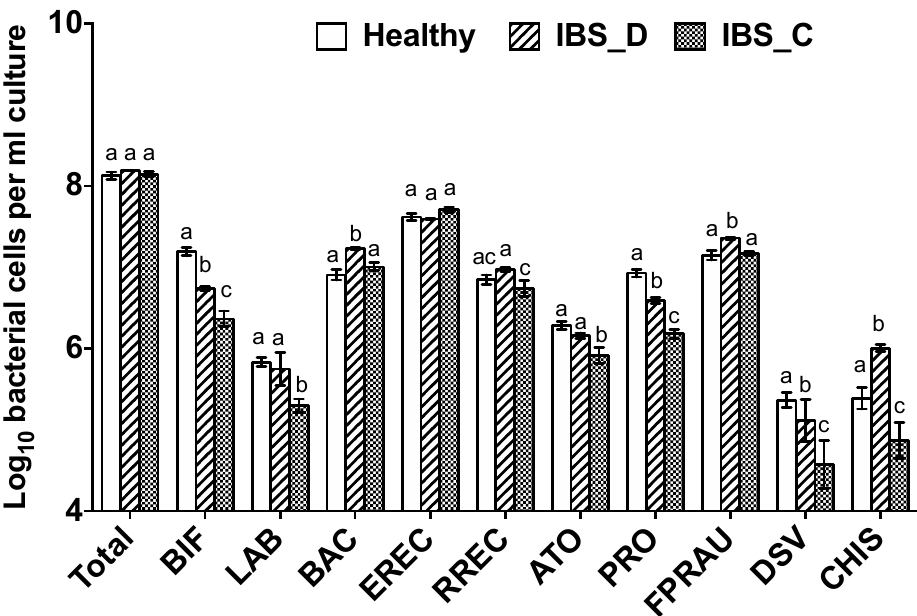
Figure 1. Baseline bacteria profile as detected by flow-FISH from faeces of healthy donors (n = 5) and IBS constipation-predominant IBS (IBS-C) (n = 5) and diarrhoea-predominant IBS (IBS-D) (n = 5) donors. Different letters indicate statistically significant differences within each bacteria group ( p < 0.05).